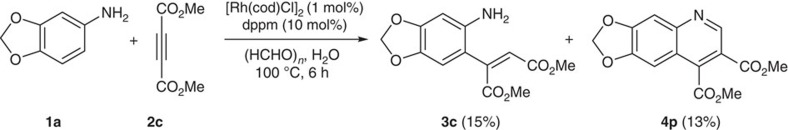
Evidence for the formation of C–C bonded intermediate.Reaction of 1a with DMAD (dimethyl acetylenedicarboxylate) 2c.